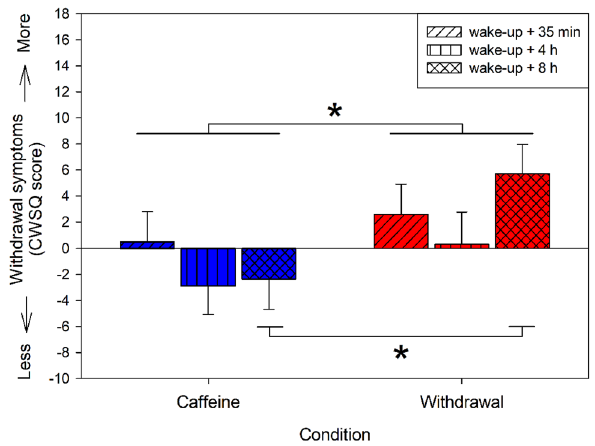
Figure 3. Relative withdrawal symptoms in the caffeine and withdrawal condition (i.e. withdrawal score of the caffeine and withdrawal condition respectively minus the score of the placebo condition) assessed 35 min, 4 h, and 8 h after wake-up on day ten of treatment. Depicted are mean values and standard errors of the relative values (i.e. difference to placebo). Overall, volunteers reported more withdrawal symptoms in the withdrawal condition compared to the caffeine condition ( p < 0.05). This difference was particularly present 8 h after wake-up during withdrawal compared to caffeine ( p <